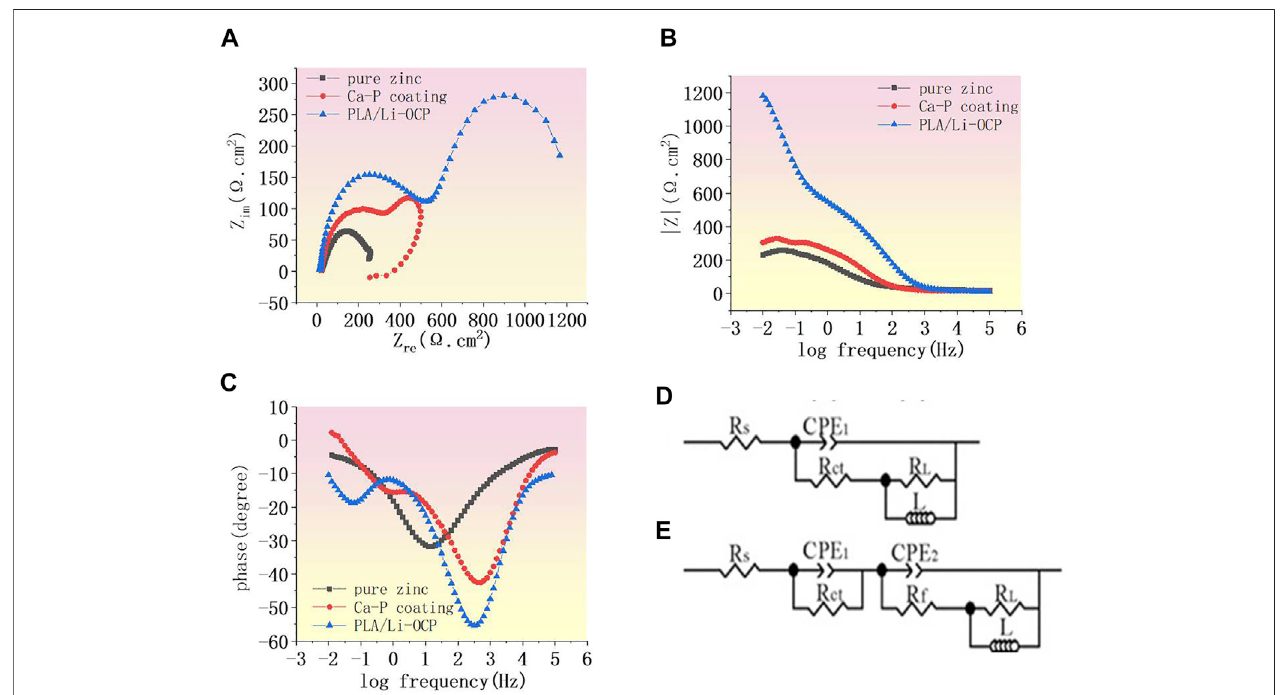
FIGURE 4 | (A) Nyquist curves of studied samples, (B) Bode curves of impedance and (C) Bode curves of phase angle, and (D, E) equivalent